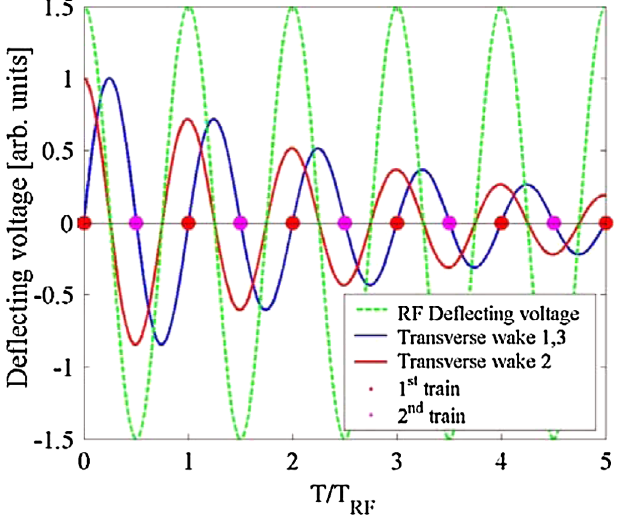
FIG. 12. (Color) Sketch of the wakefield profiles generated by the first bunch of one train assuming a general trajectory of the bunch with a 1 ; 2 ; 3 (cid:1) 0 . In the figure we considered the case of two recombined trains of bunches (1st and 2nd train). The numbers 1, 2, and 3 are related to the different types of wakes generated by the a 1 ; 2 ; 3 trajectory